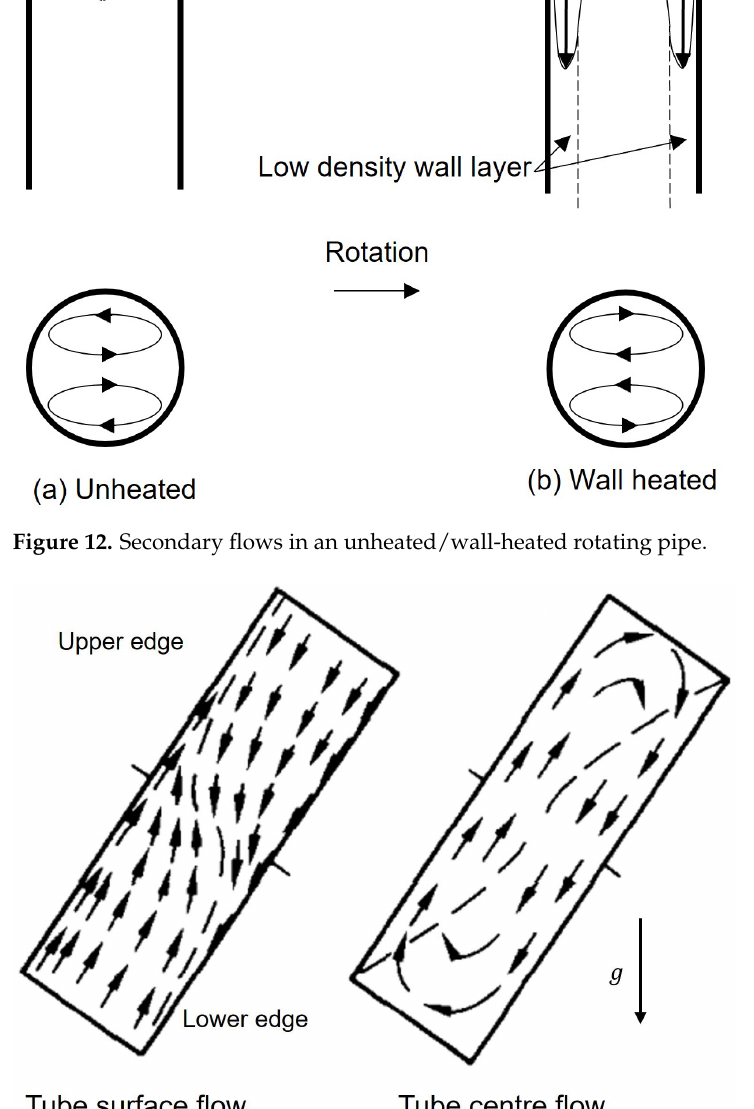
Figure 14. Heat transfer rates in an inclined closed thermosyphon with water (data from [54]; 𝑡𝑡 𝑐𝑐𝑐𝑐 = 𝛽𝛽𝑔𝑔𝐷𝐷 4 ∆𝑇𝑇 / 𝜈𝜈𝐽𝐽𝐿𝐿 ) . However, Lock and Zhao [56] pointed out that the analogy between Coriolis force effects and a tilted thermosyphon is not correct. The Coriolis forces in a rotating system are independent of the temperature field, while lateral buoyancy forces in a stationary system are not. They reported a numerical study on a single-phase radial rotating ther- mosyphon in the shape of a rectangular cavity with a length/width ratio of 5. The cavity was horizontally placed, rotating around a vertical axis. The fluid was assumed to be vis- cous and incompressible, and the flow was laminar and subject to the Boussinesq approx- imation. The Rayleigh number was kept at very low values (10 4 ~ 10 5 ) to allow the ther- mosyphon to operate between the upper limit of the conduction regime and the lower limit of the boundary layer regime. In particular, the role of Coriolis force effects was in- vestigated at low rotational speeds. It was found that at such speeds, the Ekman layers,